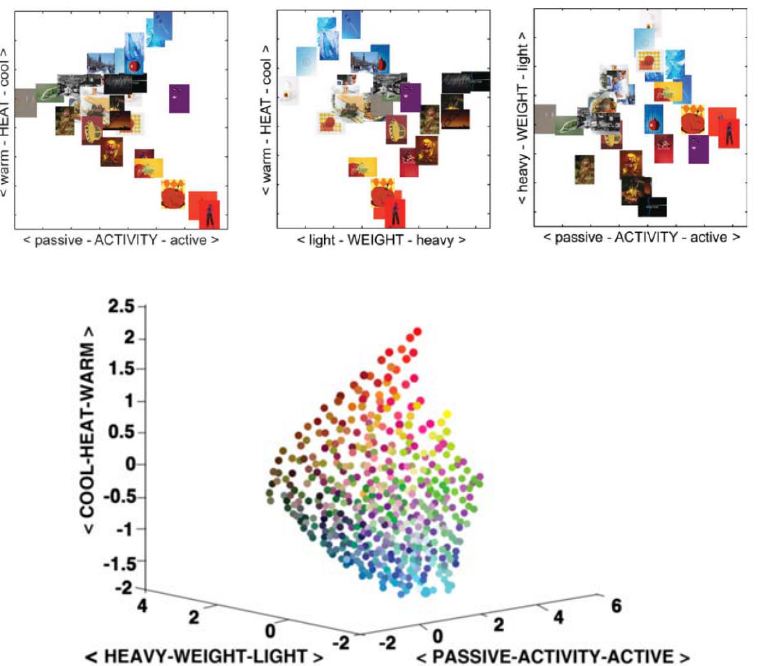
Figure 1. Three-dimensional emotional color Figure 1. Three ‐ dimensional emotional color space.